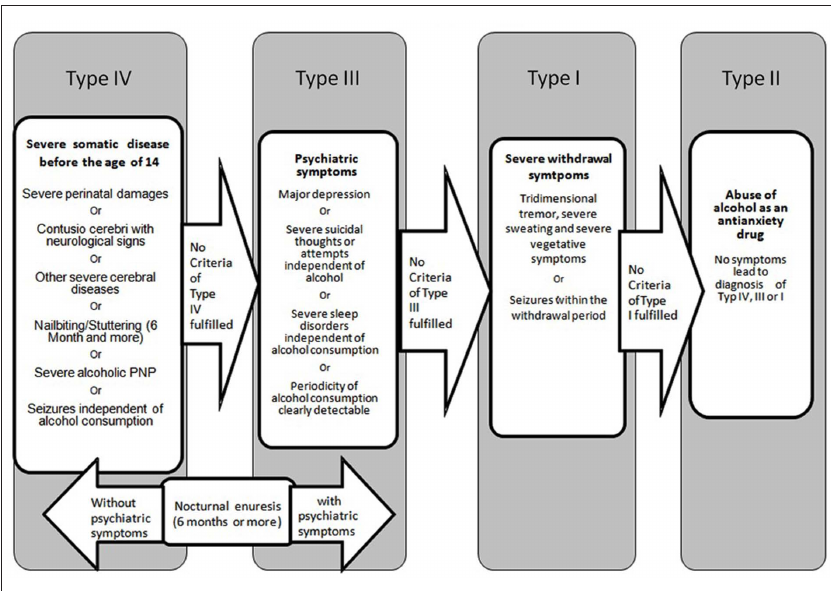
Figure 1 | Vyssoki et al. (2010) basis for diagnostic process of alcohol dependence according to Lesch’s